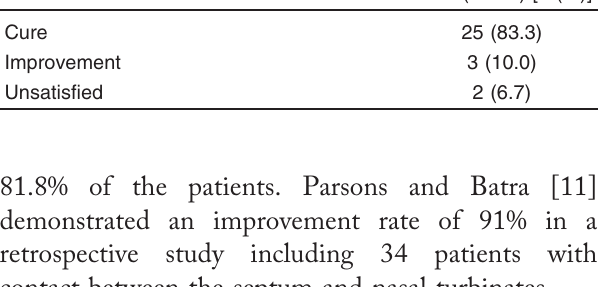
Table 4 Outcome distribution of the study group